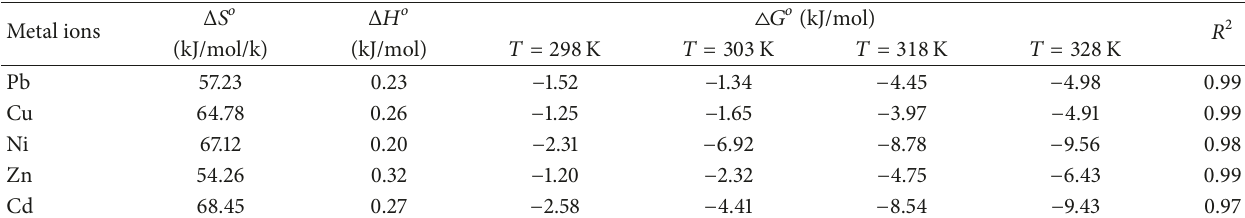
Table 4: Kinetic parameters for the binding of considered metal ions onto FGCX. Metal